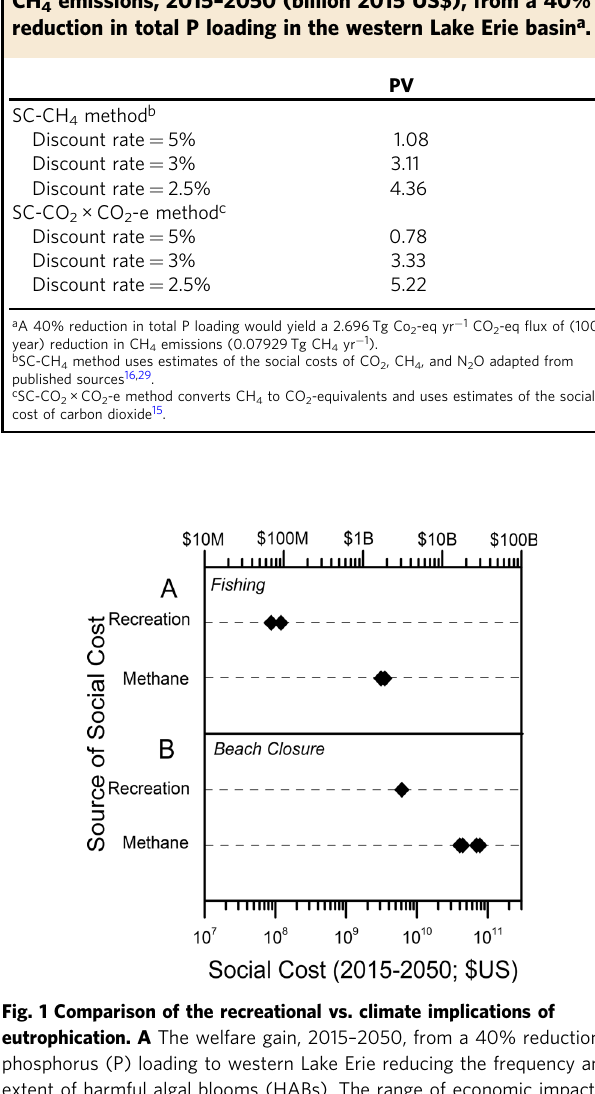
high chlorophyll from HABs as well as from chlorophyll levels that would lead to moderate risk of adverse health effects from beach